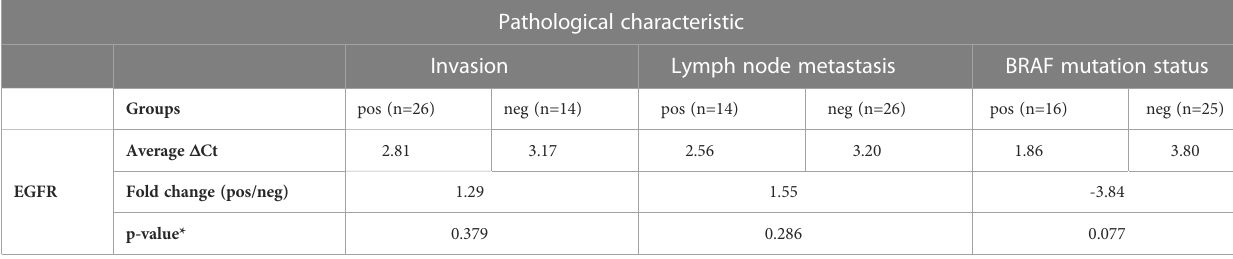
TABLE 2 EGFR expression in relation to pathological characteristics in PTC